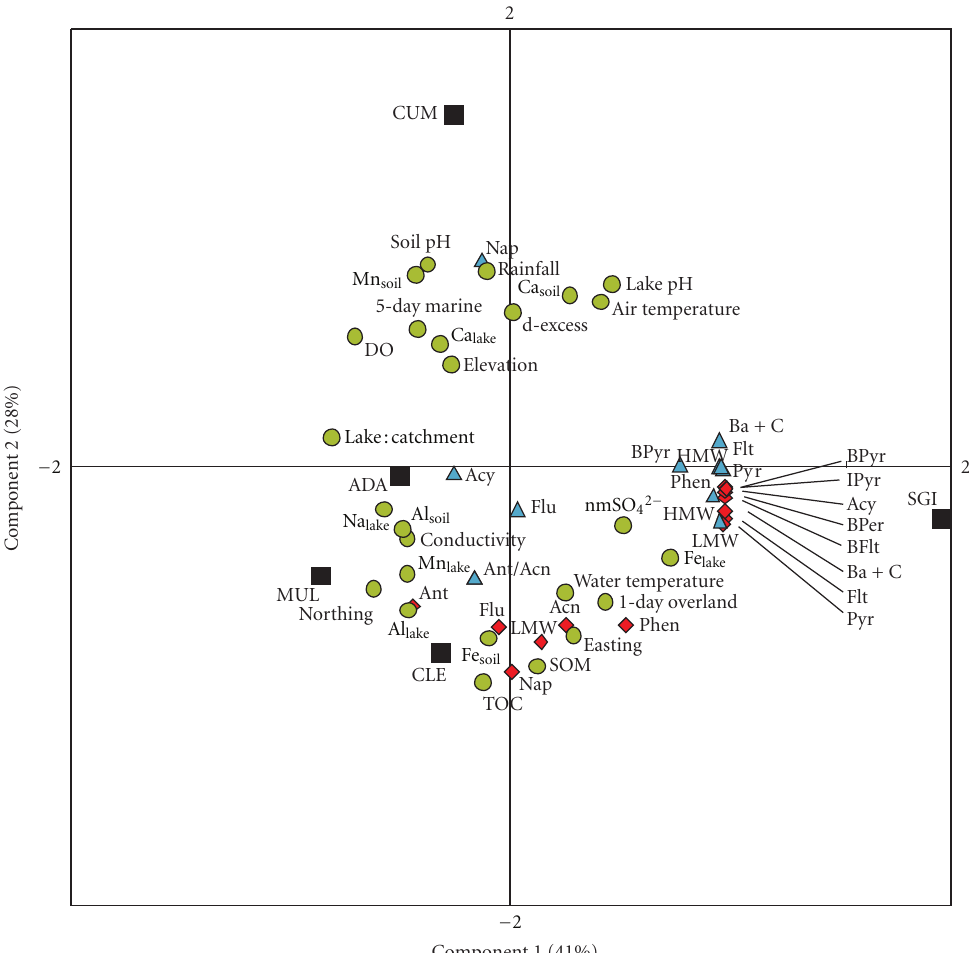
Figure 5: Principle component analysis (PCA) showing study catchments (black-filled square), lake characteristics (green-filled circles), lake PAH concentrations (blue-filled triangles), and soil PAH concentrations (red-filled diamonds). PC1 (41%), PC2 (28%), and PC3 ((not shown) 23%). Study sites: Lough Cummeenoughter (CUM), Lough Adanacleveen (ADA), Mullincrick Lough (MUL), Sgilloge Lough (SGI), and Cleevaun Lough